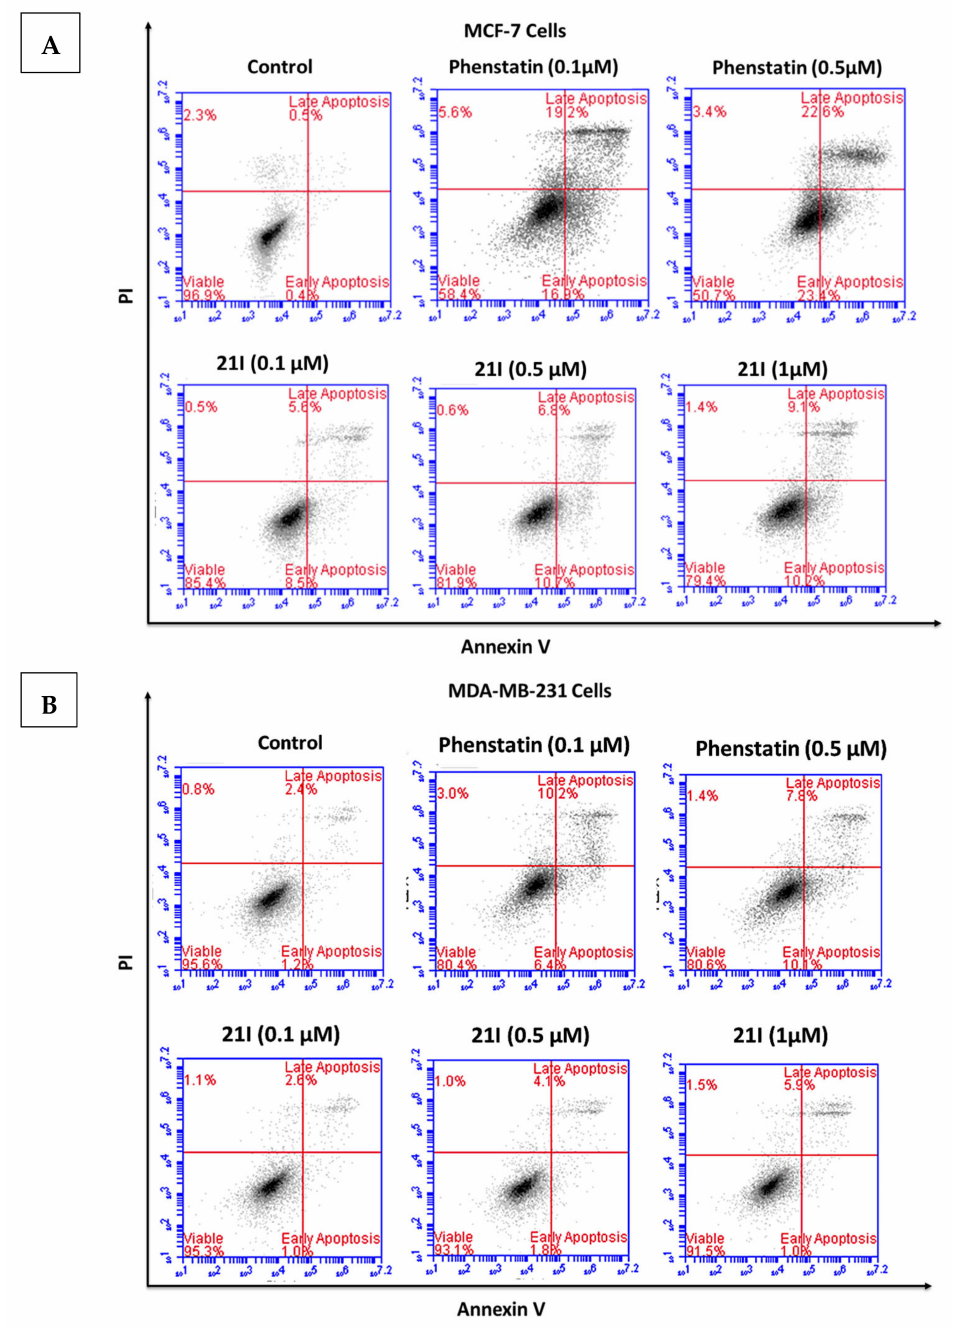
Figure 9. Compound 21l induced cell apoptosis in ( A ) MCF-7 breast cancer cells and ( B ) MDA-MB- 231 breast cancer cells. MCF-7 breast cancer cells and MDA-MB-231 breast cancer cells were treated with 21l or phenstatin ( 7a ) (1 µ M) or control vehicle (0.1% ethanol ( v / v )), and the percentage of apoptotic cells was determined by staining with Annexin V-FITC and PI. In each panel, the lower left quadrant shows cells that are negative for both PI and Annexin V-FITC, the upper left shows only PI cells that are necrotic. The lower right quadrant shows Annexin-positive cells that are in the early apoptotic stage and the upper right shows both Annexin/PI positive, which are in late apoptosis/necrosis. Control cells and cells treated with phenstatin 7a and 21l at 48 h are shown, respectively. Values represent the mean of three independent